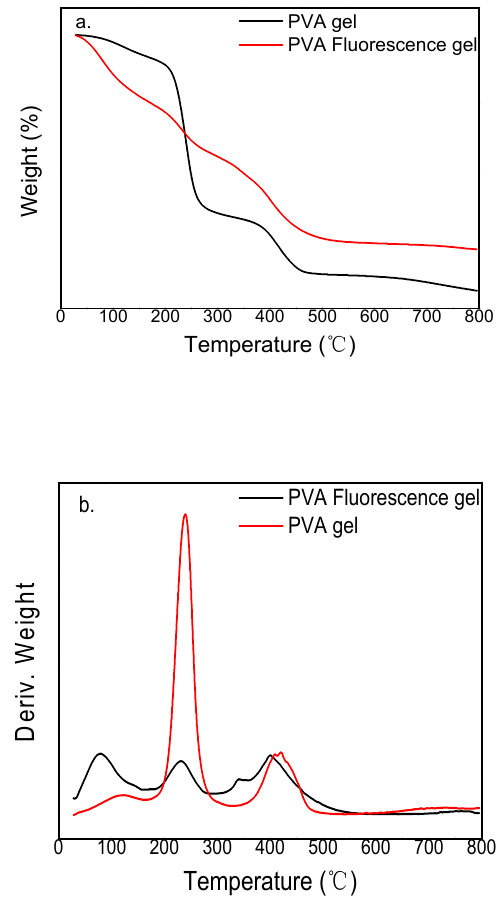
Figure 10. Thermogravimetric (TG) ( a ) and differential thermogravimentric (DTG) ( b ) curves of PVA gel and PVA fluorescent gel.